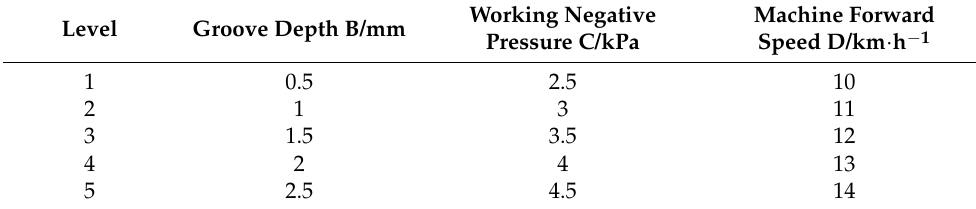
Table 2. Factor level of